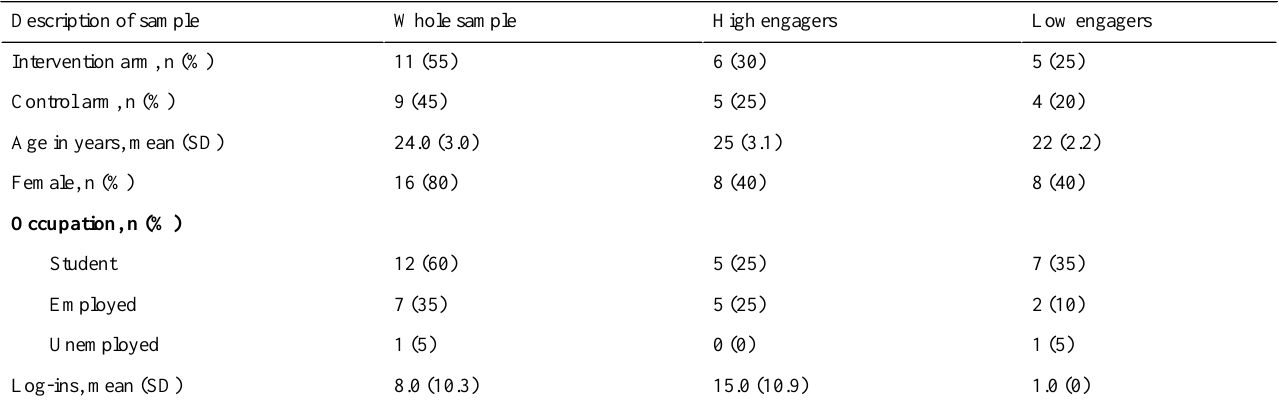
Table 1. Participant demographics, allocation in randomized controlled trial (RCT), and use